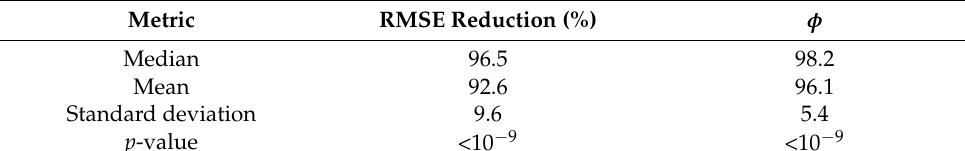
Table 1. Improvement in MRF signal matching using the time fractional instead of the integer order Bloch model. Displayed are the root-mean-squared error (RMSE) reduction and corresponding improvement in the dot product computed angle, φ . The t-test p -values testing whether the RMSE and φ improvements are significantly greater than zero have been provided.